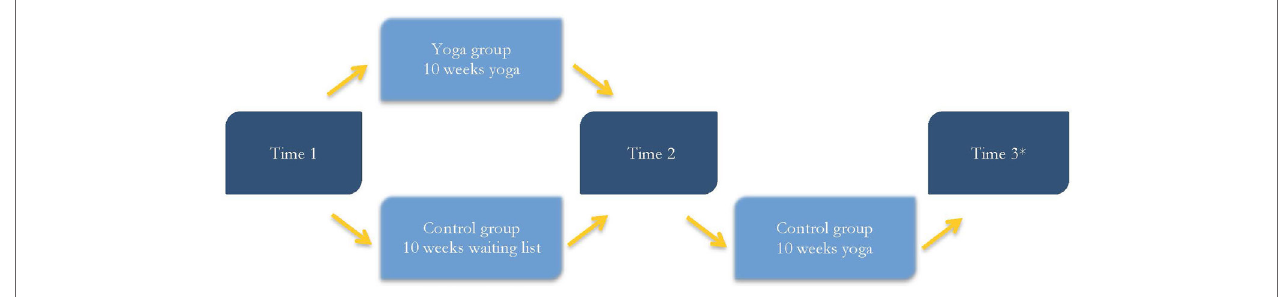
FigUre 1 | The study procedure after participants had been assigned to the yoga or control group. *Time 3 assessment was